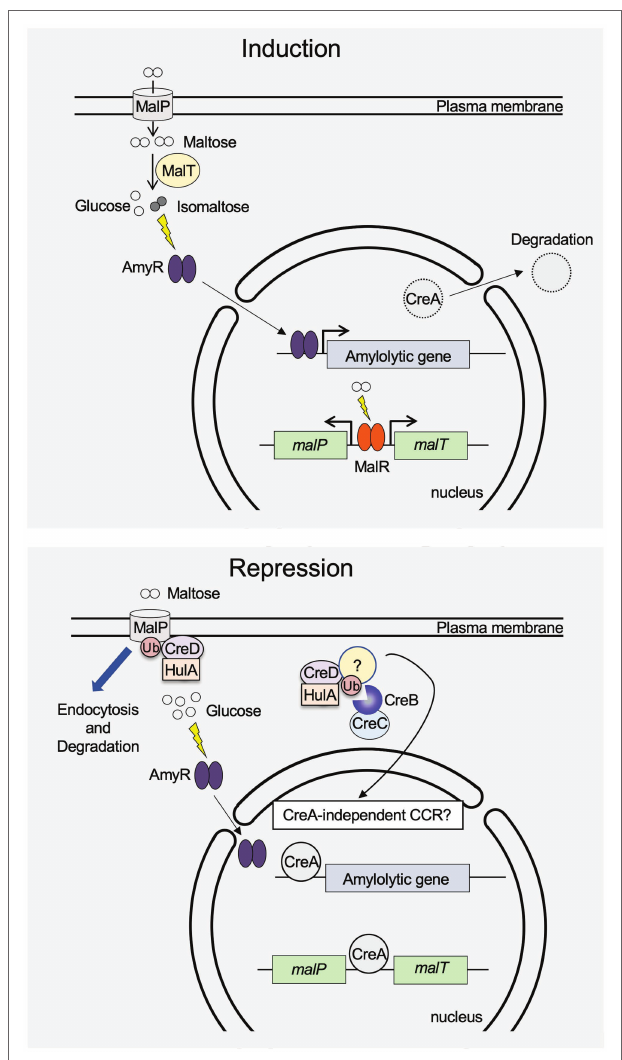
FIGURE 1 | Schematic model for induction and repression of amylolytic gene expression in A. oryzae . When maltose is added to the culture medium, MalR induces malP and malT expression. After the uptake of maltose into the cell by MalP, AmyR nuclear transfer is triggered by isomaltose, which is presumably generated by the glycosyltransferase activity of MalT. CreA is exported from the nucleus to the cytoplasm, where it is degraded, and amylolytic gene expression is induced by activated AmyR. In the presence of glucose, the expression of malP and malT is repressed by CreA. Moreover, MalP protein is brought into the cell by endocytosis mediated by HulA and CreD, and is degraded at the vacuole. Although a high concentration of glucose induces AmyR nuclear transfer, expression of amylolytic genes is strongly repressed by CreA. The unknown protein stabilized by the CreB- CreC complex presumably regulates CreA-independent carbon catabolite repression